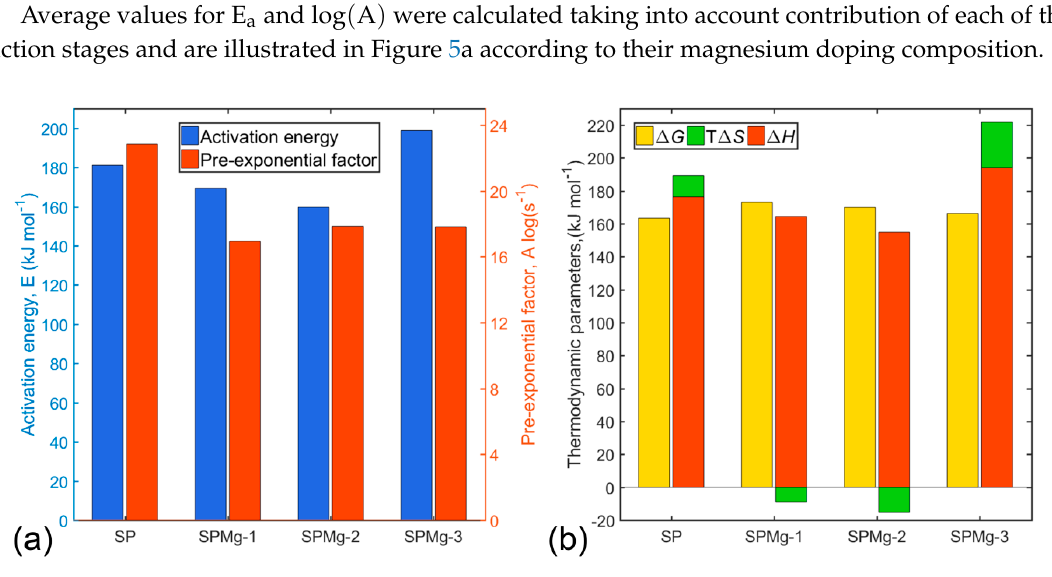
Figure 5. Average values for ( a ) E a and log ( A ) , and ( b ) ∆ G (cid:2999) ,T (cid:2926) ΔS (cid:2999) and ΔH (cid:2999) from polymer matrix thermal decomposition process of synthesis precursors prepared with different Mg doping concentrations.